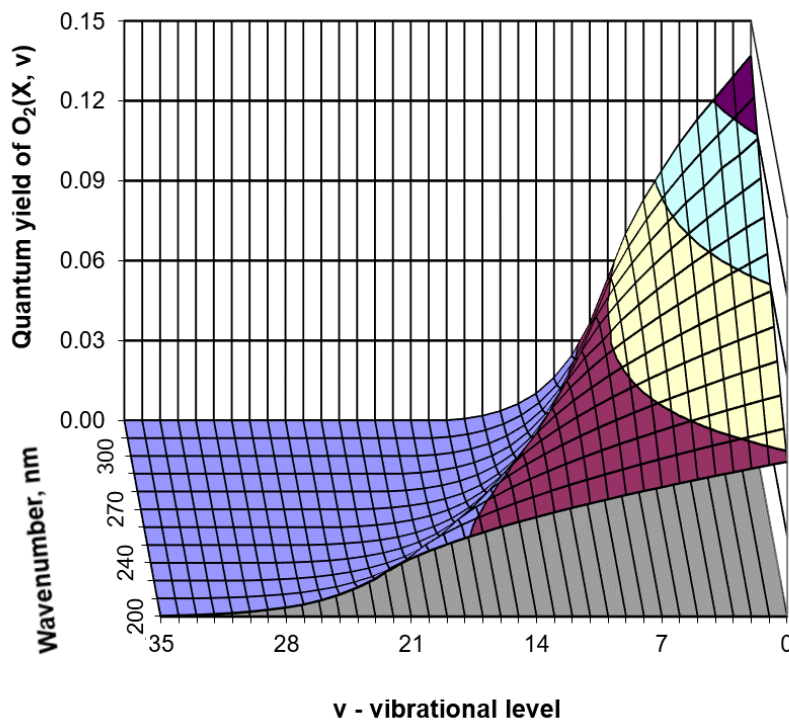
Figure 2. Quantum yields of O 2 (X 3 Σ g − , v = 0–35) formation in the triplet channel of ozone photolysis depending on wavelength [40]. Colors correspond to subintervals of quantum yield values: violet (0.00–0.03), dark red (0.03–0.06), yellow (0.06–0.09), blue (0.09–0.12), purple (0.12–0.15).